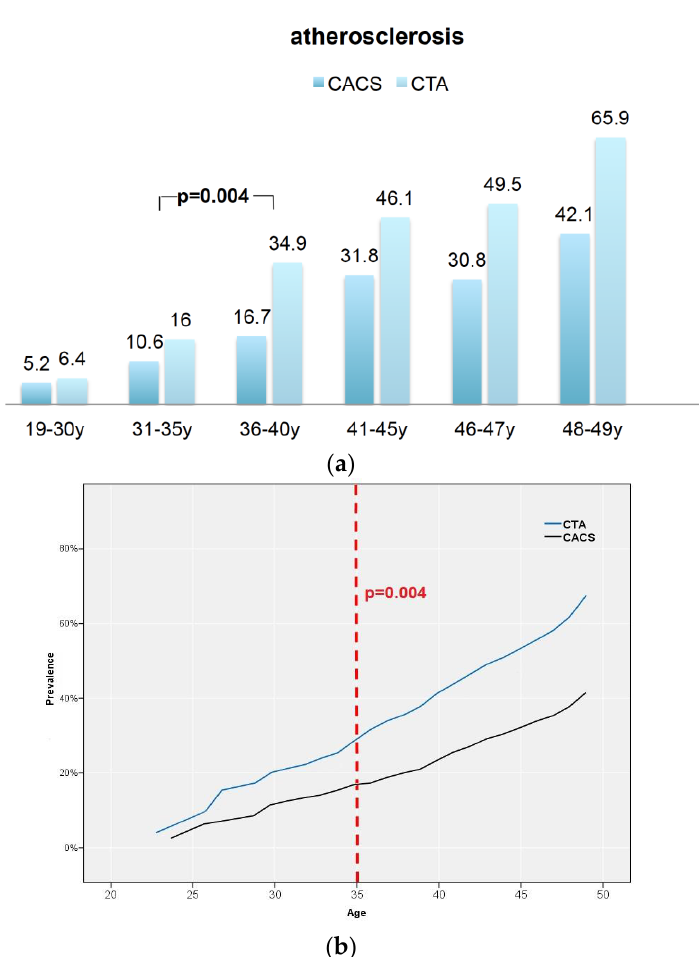
Figure 2. ( a ) Atherosclerosis based on the coronary artery calcium score (CACS) compared to coronary CTA. Atherosclerosis prevalence increased from 16% to 34.9% in patients older than 35 years based on CTA ( p = 0.004) ( b ). N = percentage (%).